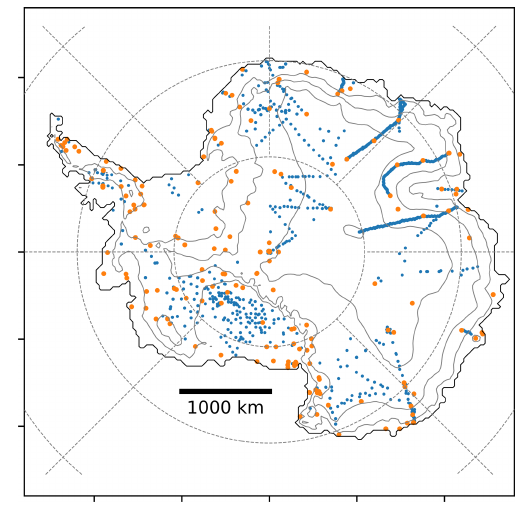
Figure A2. Location of automatic weather stations and SMB observations in Antarctica and used in this study.